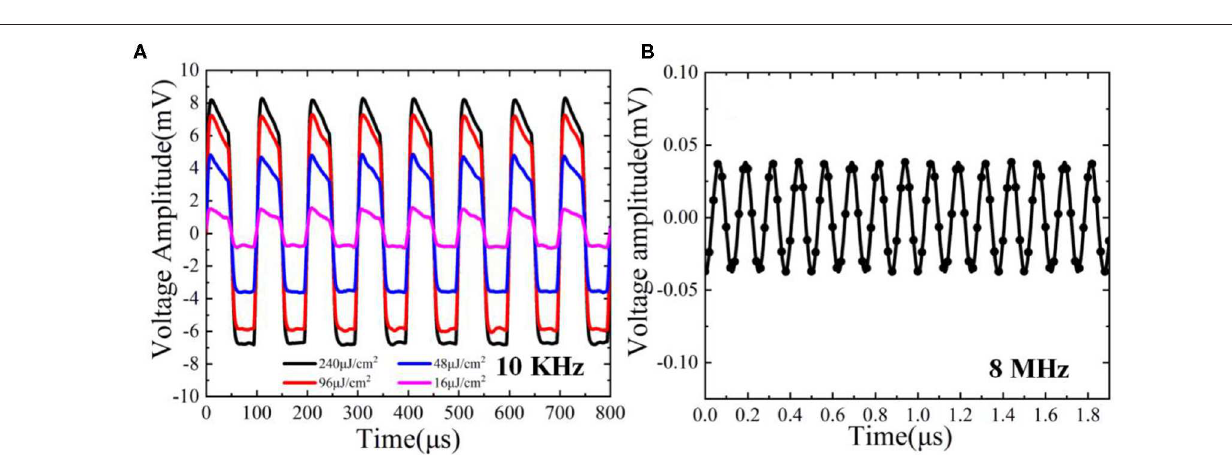
Frontiers in Physics |